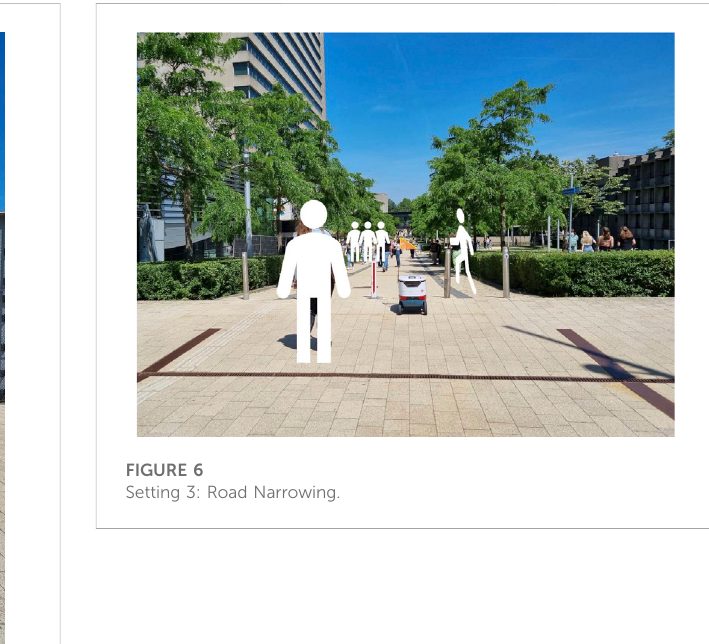
FIGURE 6 Setting 3: Road Narrowing.